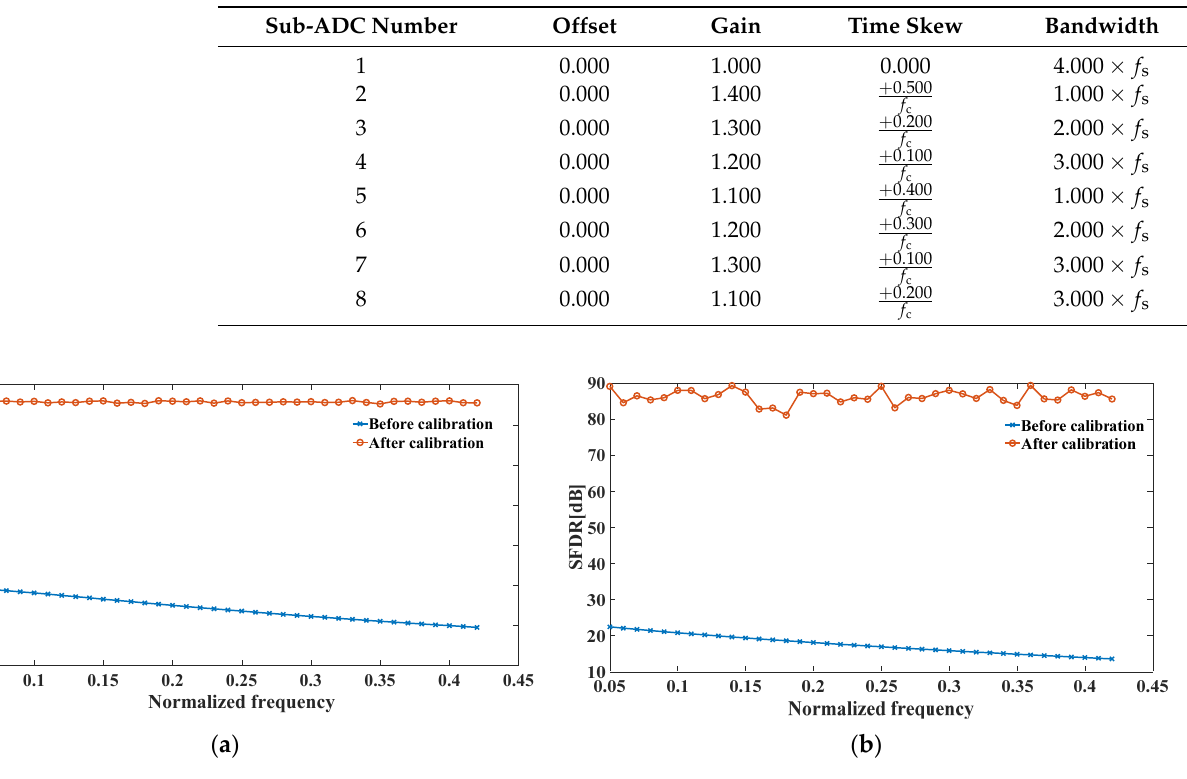
Figure 7. Performances of the proposed method. ( a ) The SNDR of TI ‐ ADCs with different frequencies; ( b ) the SFDR of TI ‐ ADC with different frequencies.